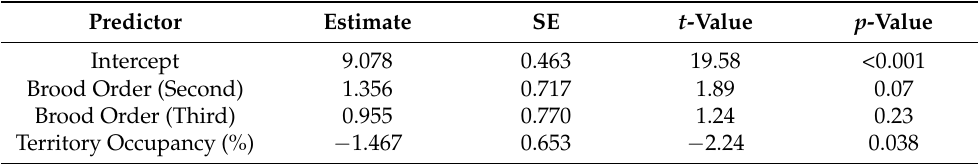
Table 1. Results from a reduced model selected from a full general linear model (GLM) analyzing natal dispersal distance of Black-shouldered Kites ( Elanus caeruleus ) in southwestern